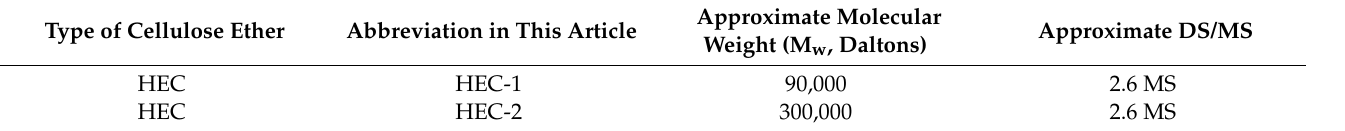
Table 1. Various commercial grades of cellulose ethers were investigated in this study. The polymers were obtained from Ashland LLC, Wilmington, DE, USA. Data were compiled from internal reports produced by the Measurement Science department at Ashland LLC. In addition to the abbreviations already introduced in the body of the text, the following apply in the table: HM = hydrophobically modified; Me = methyl; HP =